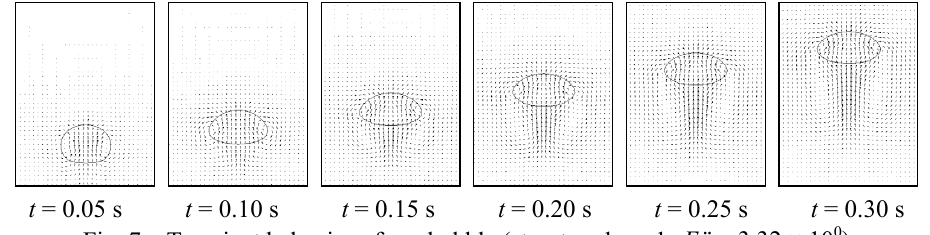
Transient behavior of gas bubble (structured mesh, Eö = 3.32 × 10 0